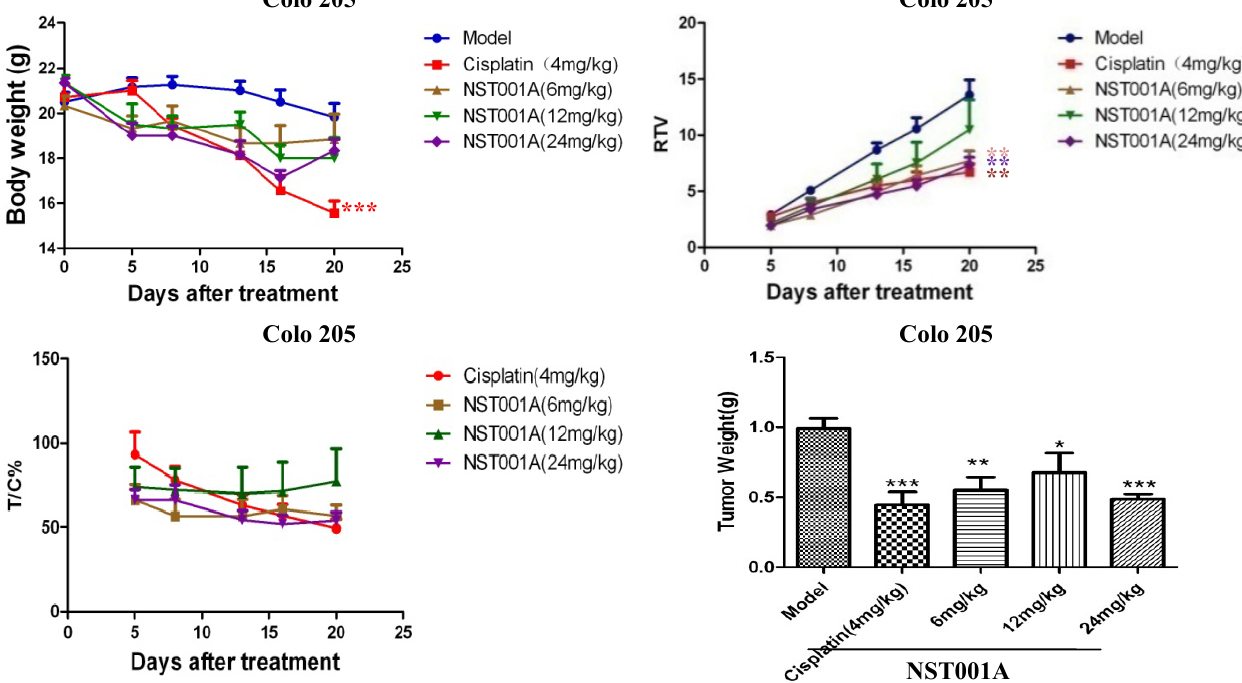
Figure 3. Effects of NST001A on the growth of Colo 205 xenografts in nude